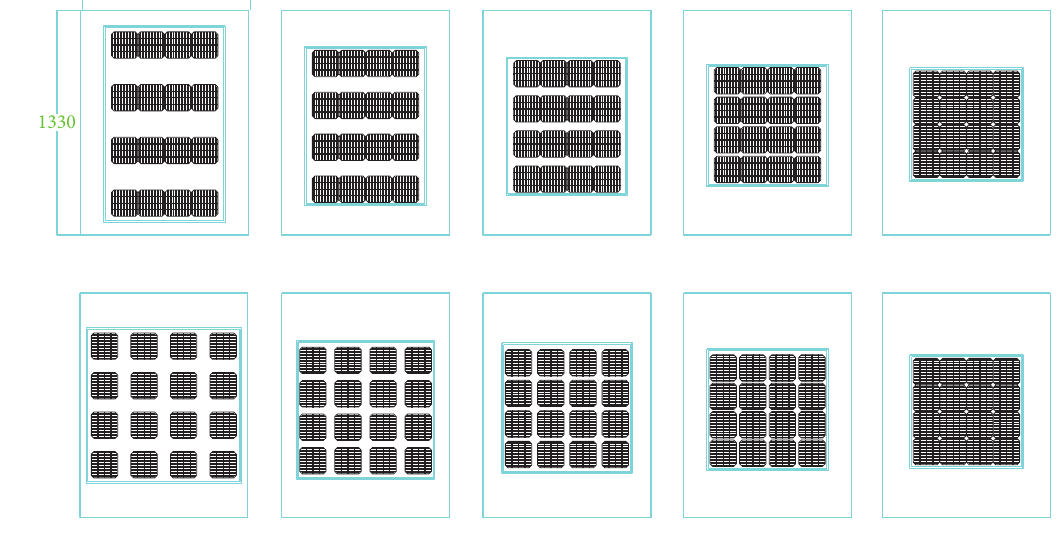
Figure 7: Bifacial BIPV panel with frames.